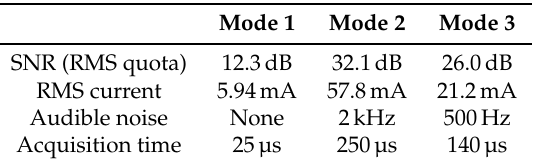
Figure 1. Case comparison between 20kHz, 2kHz and hybrid switching. Shaded areas represent the time it takes to measure the full rise-time. Samples are taken at a rate of 500Hz. Note the different scales on the y-axis for each case. Table 1. Comparison of switched operation